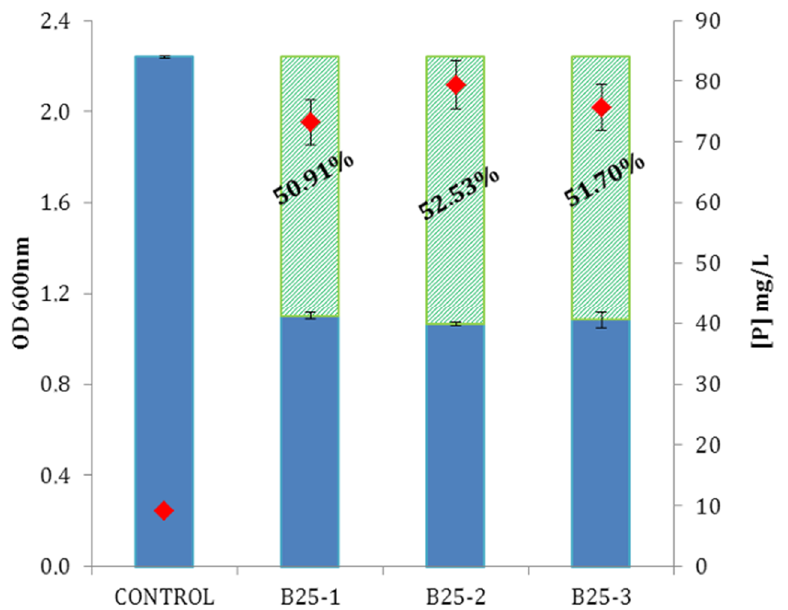
Figure 5. Phosphorus solubilization ability of Bacillus velezensis B25 compared to control in 3 inde- pendent experiments (B25-1, B25-2, and B25-3): OD 600 nm (blue columns); percentages of OD 600 nm de- crease of B25 cultures compared to control (green columns); phosphorus rates in culture superna- tants in mg L −1 .